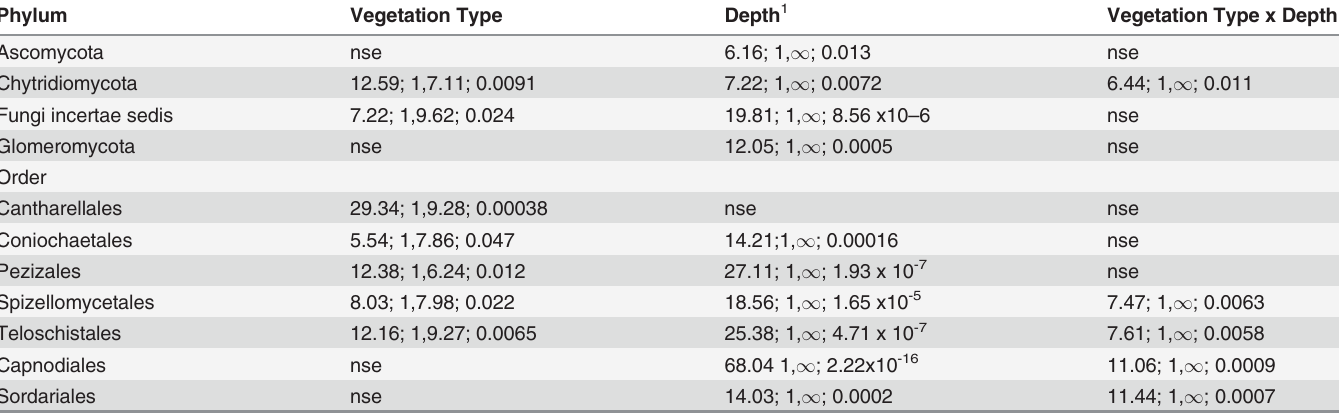
Table 3. Fungal phyla and orders for which vegetation type, depth and/or an interaction between the two signi fi cantly impacted their proportion in the sequence